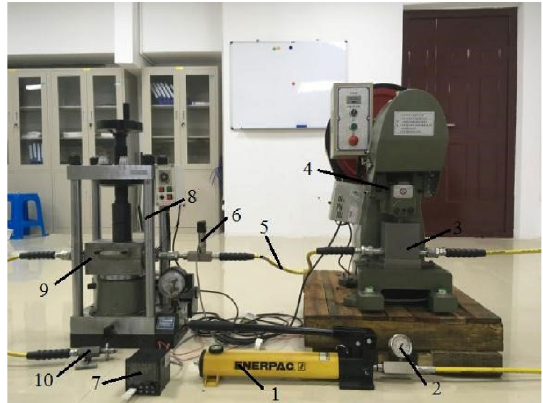
Figure 1 Experimental platform for the hydroforming of rectangular tubes